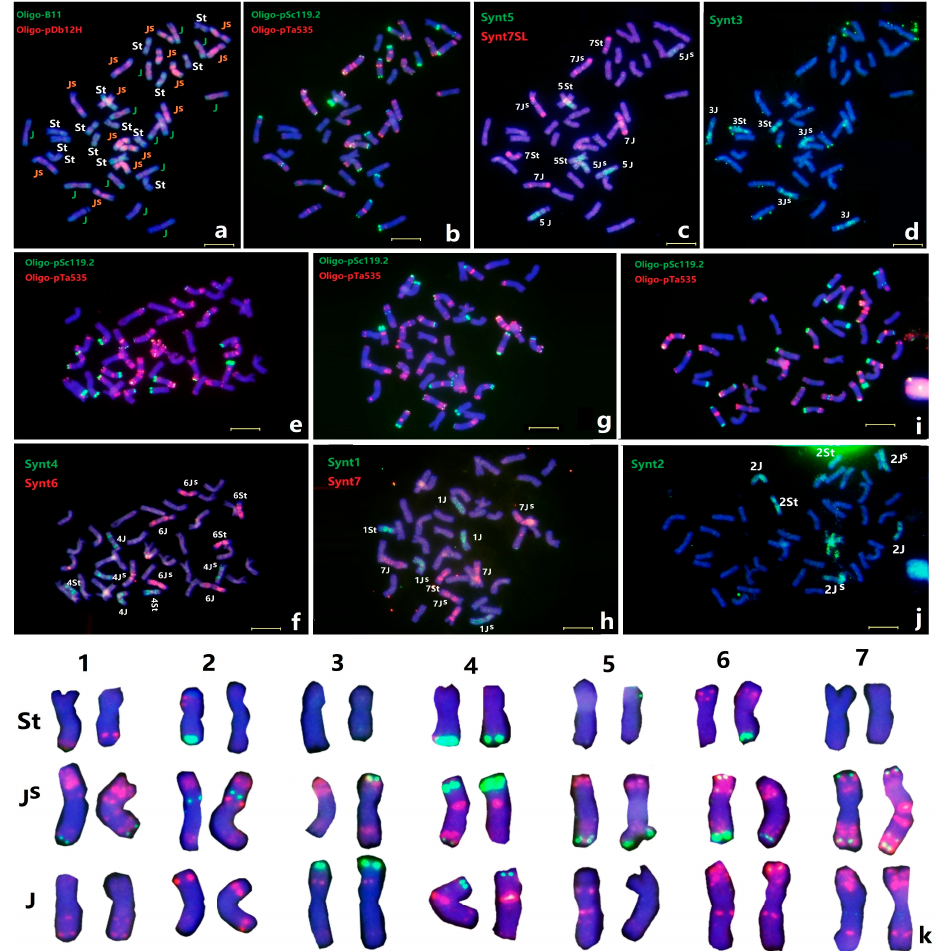
Figure 1. Sequential FISH for Th. intermedium PI440043 with probes Oligo-B11 + Oligo-pDb12H ( a ), Oligo-pSc119.2 + Oligo-pTa535 ( b , e , g , i ), Synt5 + Synt7SL ( c ), Synt3 ( d ), Synt4 + Synt6 ( f ), Synt1 and Synt7 ( h ) and Synt2 ( j ), respectively. The chromosomes were counterstained with DAPI (blue). ( k ) Karyotypes of Thinopyrum intermedium PI440043 with homoeologous and subgenome assignment were subjected to sequential ND-FISH with Oligo-pSc119.2 + Oligo-pTa535. Bars, 10 μ m.